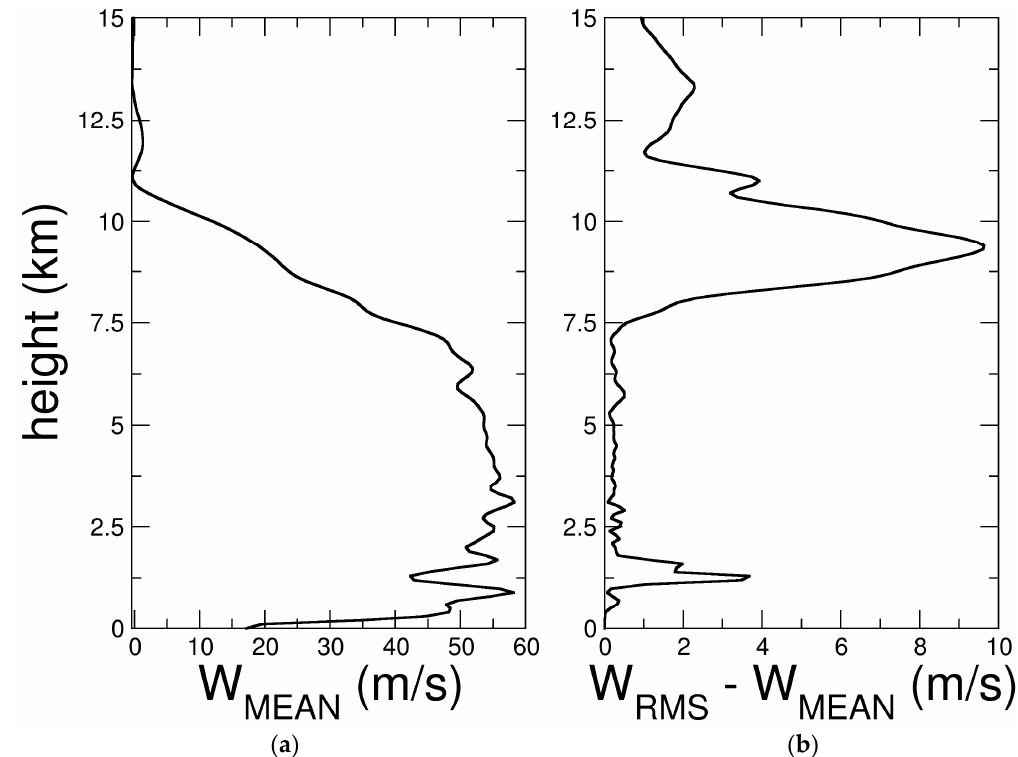
Figure 4. ( a ) The mean centre-line vertical velocity W MEAN as a function of height; ( b ) the profile of difference between root-mean square vertical velocity W RMS and W MEAN as a function of height, indicating regions of enhanced turbulence. Both plots use time averaging.